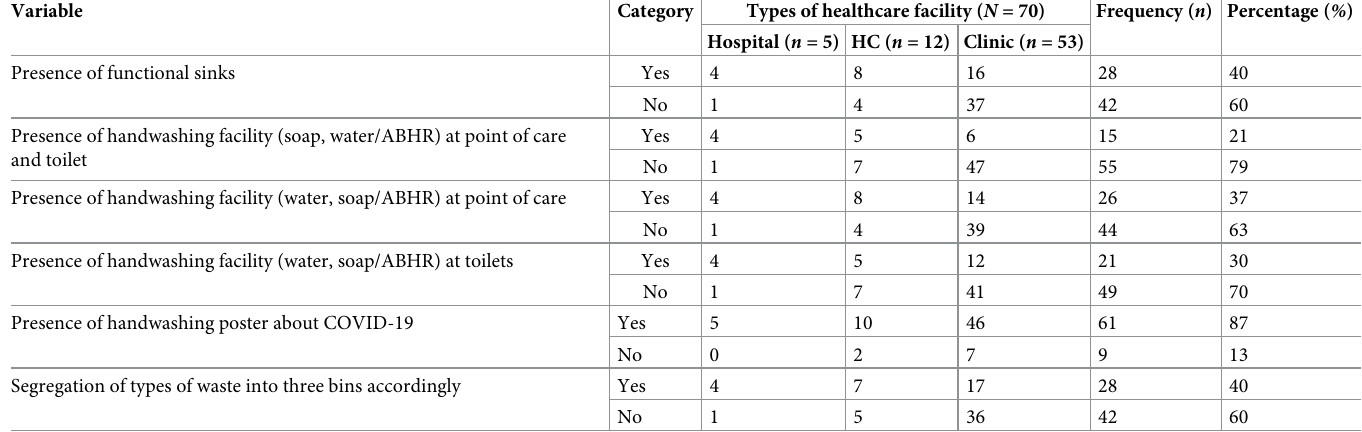
Table 4. Hygiene facilities based on the type of healthcare facility in Northeastern Ethiopia from July to August 2020.